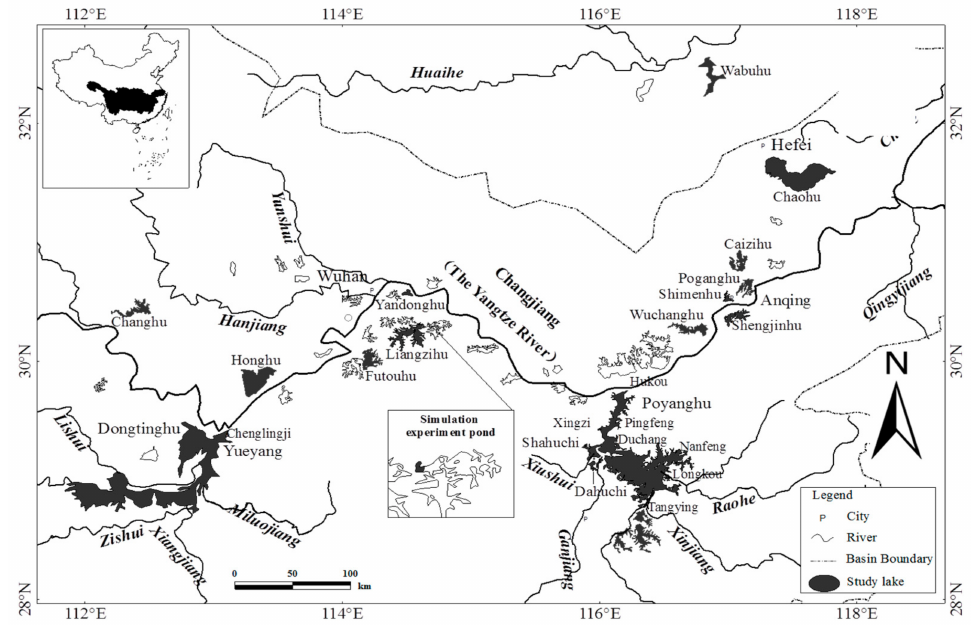
Figure 1. The location of the 24 lakes studied,